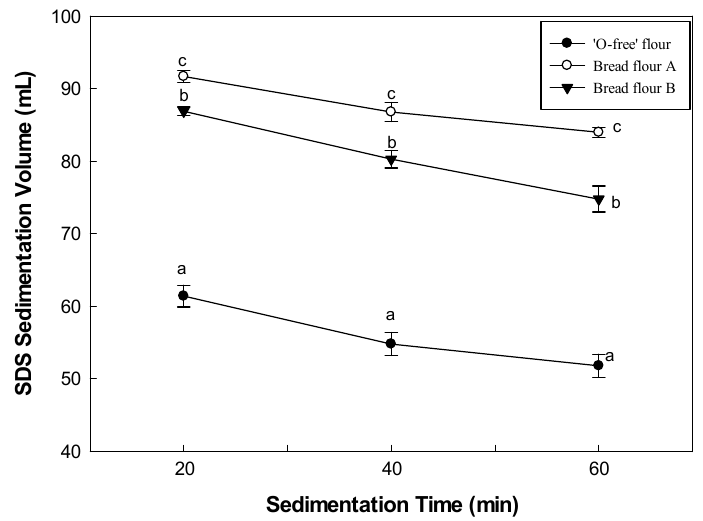
Figure 2. SDS sedimentation volume of the flour samples. The different letters above the symbols in line plots are significantly different at p < 0.05, according to Tukey’s HSD test.